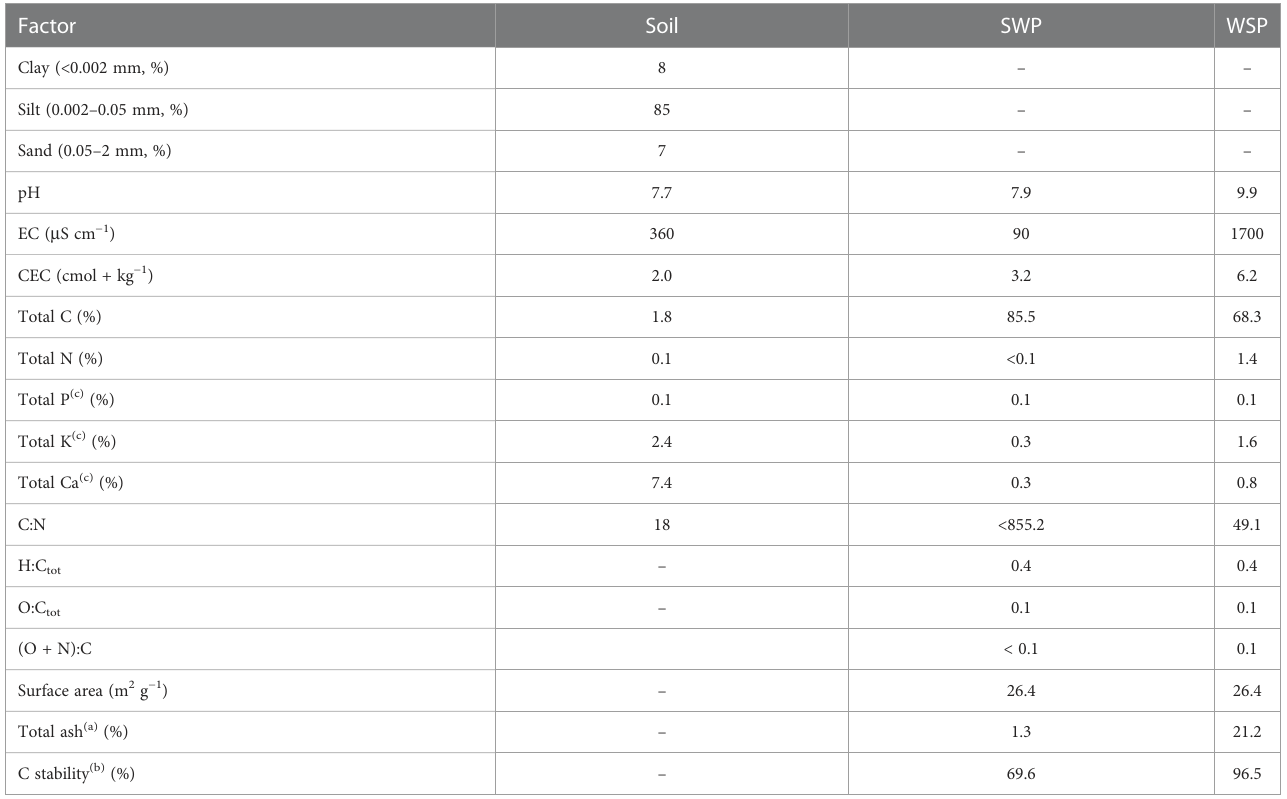
TABLE 1 Soil and biochar